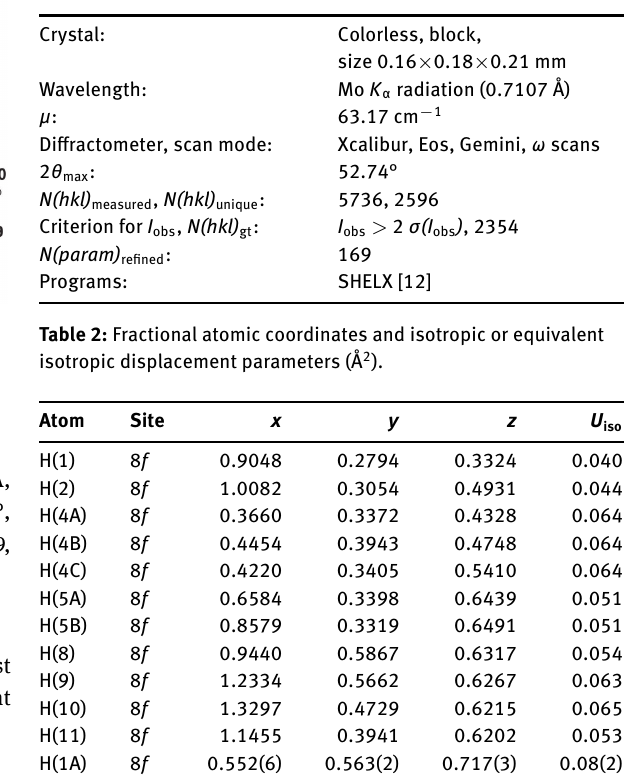
Table 1: Data collection and handling.